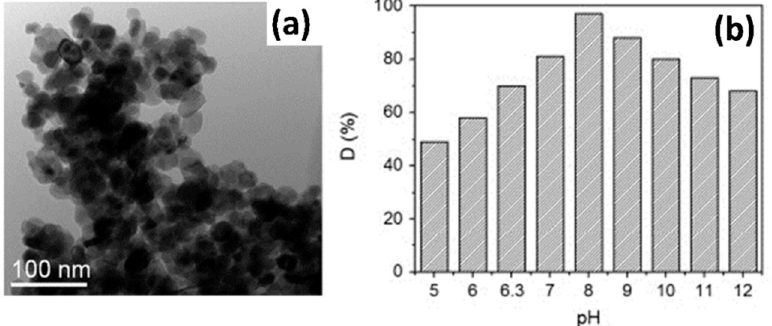
Figure 8. ( a ) TEM image and ( b ) pH e ff ect on the photodegradation of MB over Ta-doped ZnO (reproduced with permission from [64]. Copyright Elsevier Science Publishers,